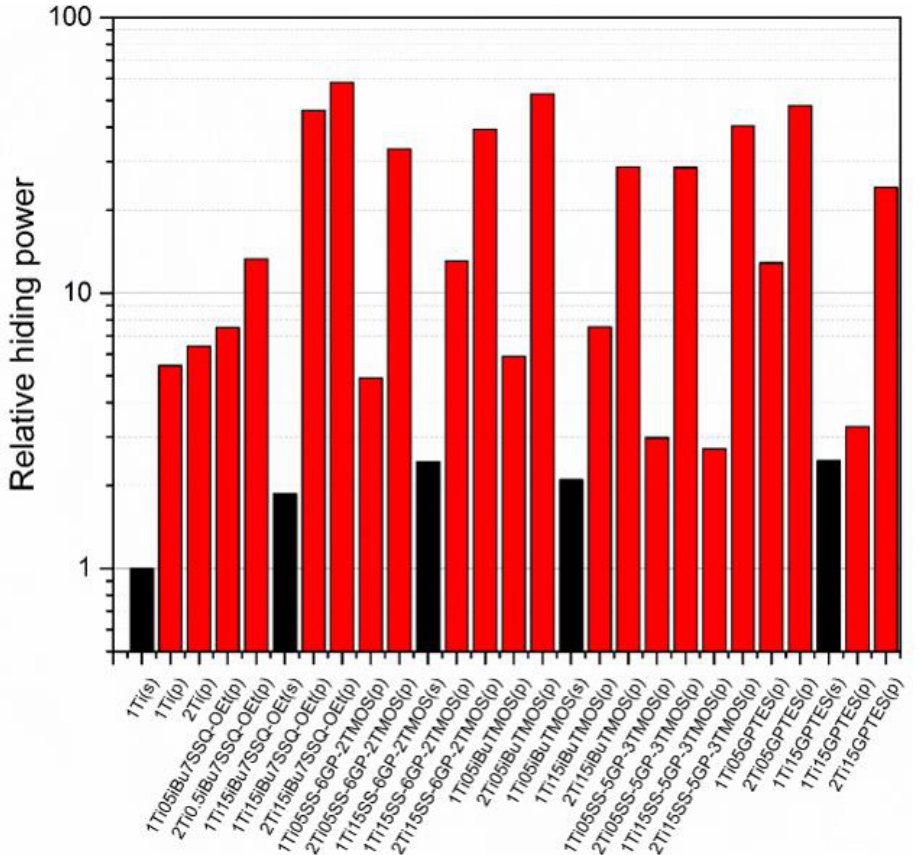
Figure 11. Relative hiding power of the pigmented epoxy systems.